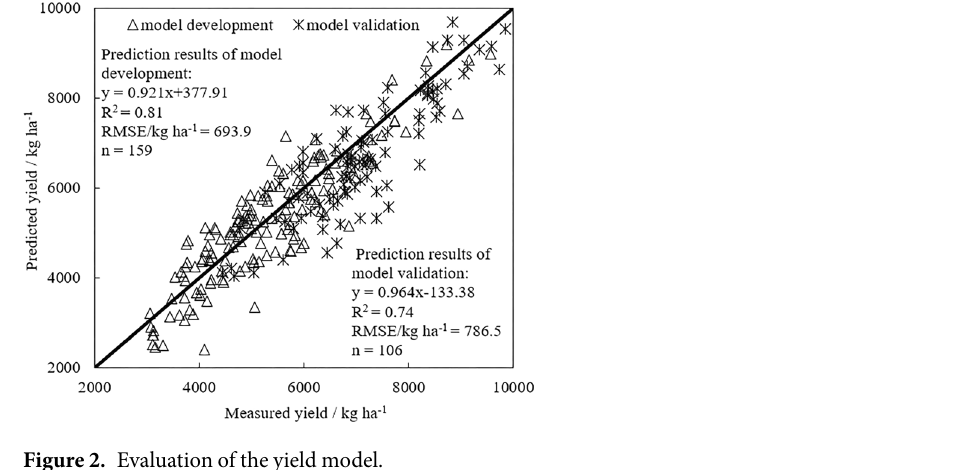
Figure 2. Evaluation of the yield